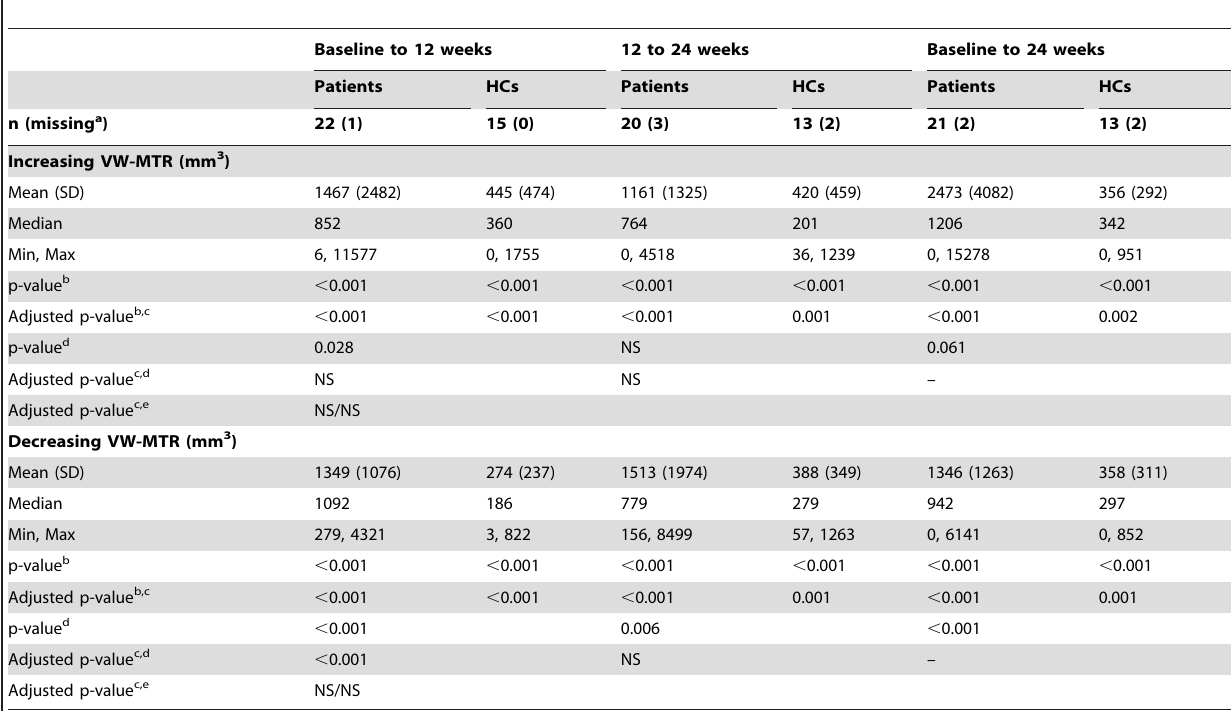
Table 3. Change in VW-MTR in NABT over time – comparison between patients and HCs with increasing and decreasing VW-MTR (mm 3